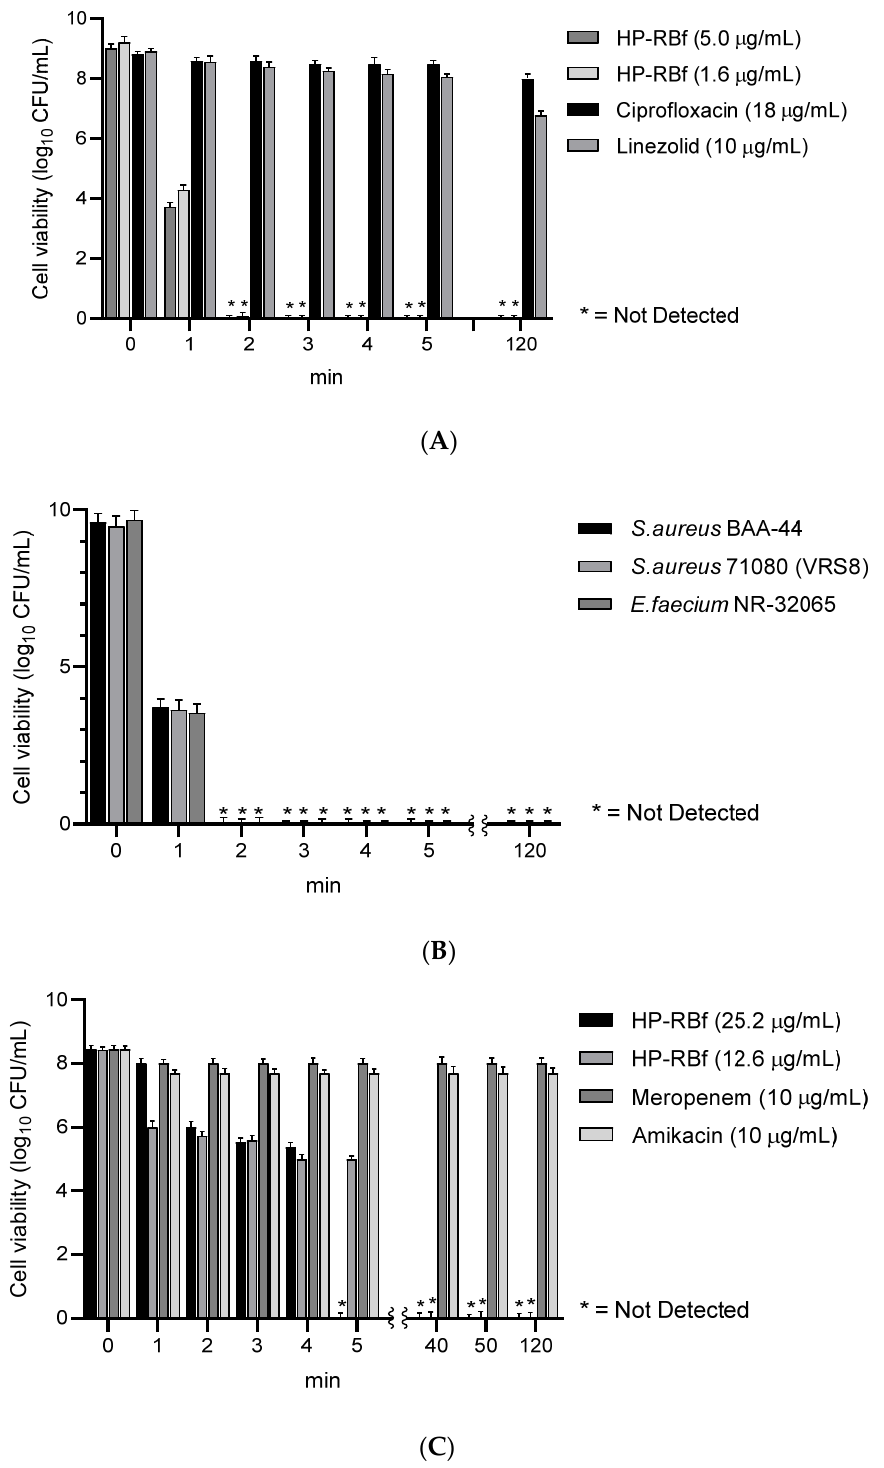
Figure 2. Time-kill kinetics of HP-RBf (10% RB in saline) against Gram-positive and -negative bacteria under the fluorescent light (17 W, 63.8 cm 2 , 0–1.1 KJ/cm 2 ). a ( A ) Time-kill kinetics of HP-RBf and representative antibiotics against S. aureus 6538TM; ( B ) Time-kill kinetics of HP-RBf against drug resistant Gram-positive bacteria; ( C ) Time-kill kinetics of HP-RBf and anti-Gram-negative antibiotics against B. cepacia (UCB707). a Two times the MIC concentration was applied: 3.2 μ g/mL for S. aureus BAA-44; 0.8 μ g/mL for S. aureus 71,080 (VRS10); 1.6 μ g/mL for E. faecium NR-32065.